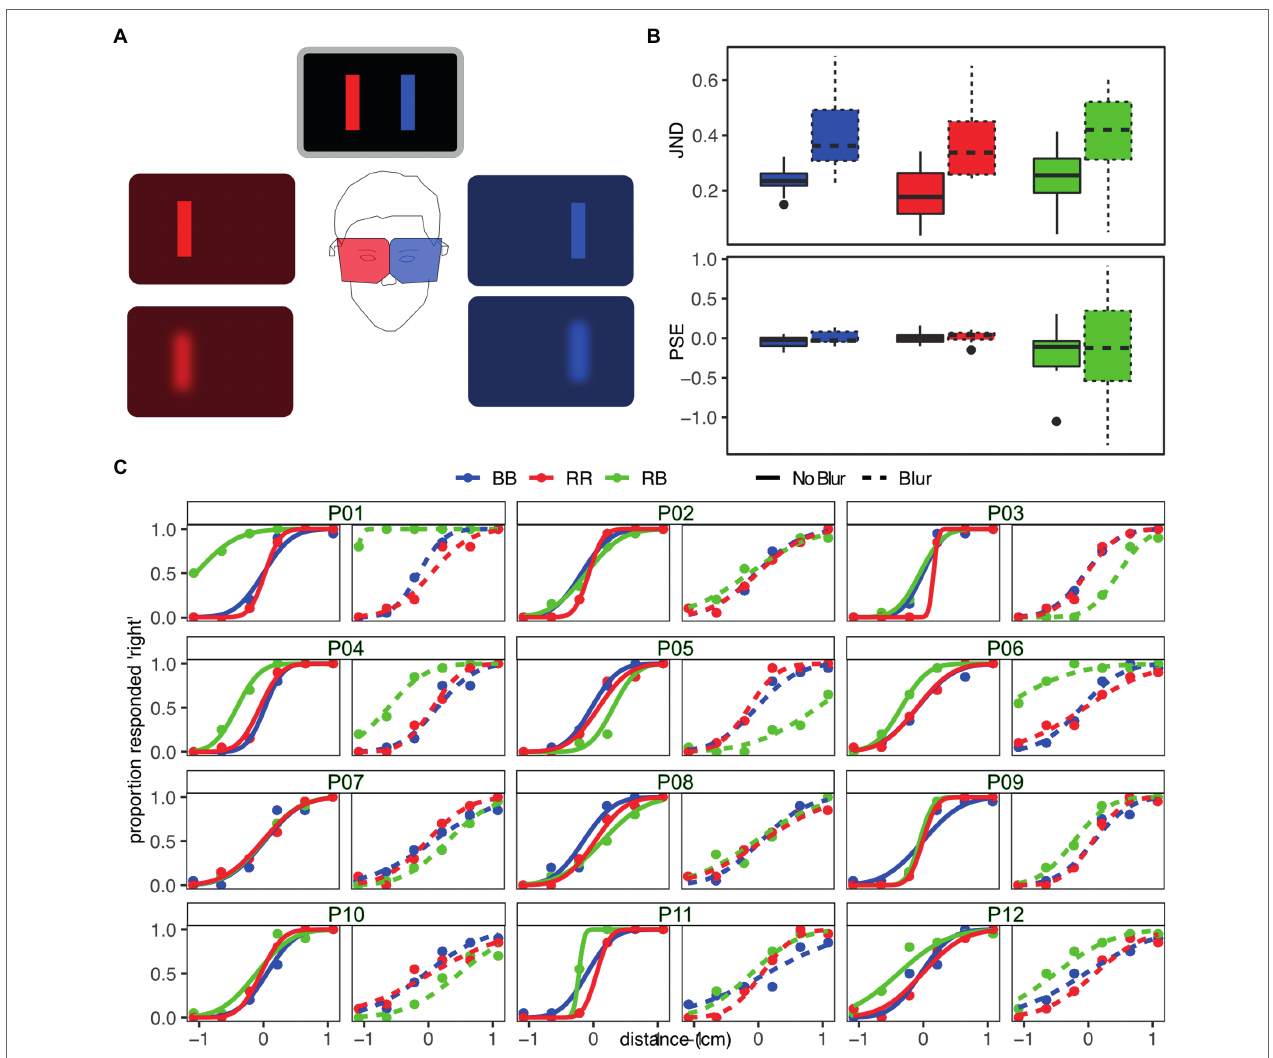
FIGURE 3 | (A) Anaglyph glasses: filters for different colors (in our case, red for the right eye, and blue for the left eye) are applied to each lens, so that different stimuli are made visible for the two eyes, provided that the colors of the stimuli match those of the filters. The localizability of the stimuli can be modulated by applying a blurring layer on each filter. (B) Boxplots of the JND (top panel) and PSE (bottom panel) for the different conditions of color and blur. (C) Psychometric curves fitted for each individual participant in all conditions of color and